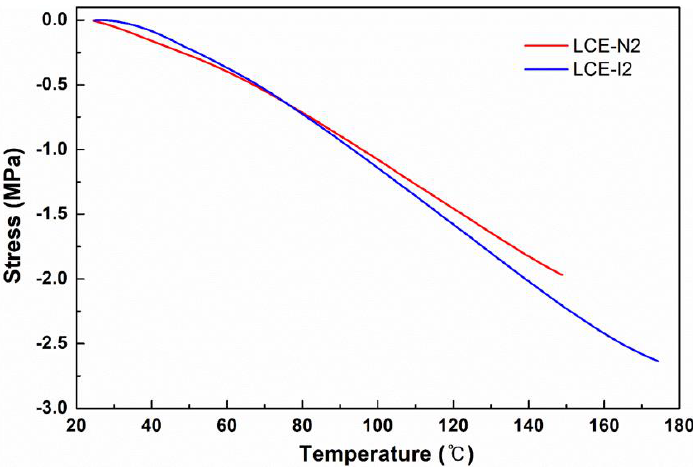
Figure 7 . Isostrain test results of planarly aligned LCE-N2 and LCE-I2. Figure 7. Isostrain test results of planarly aligned LCE-N2 and